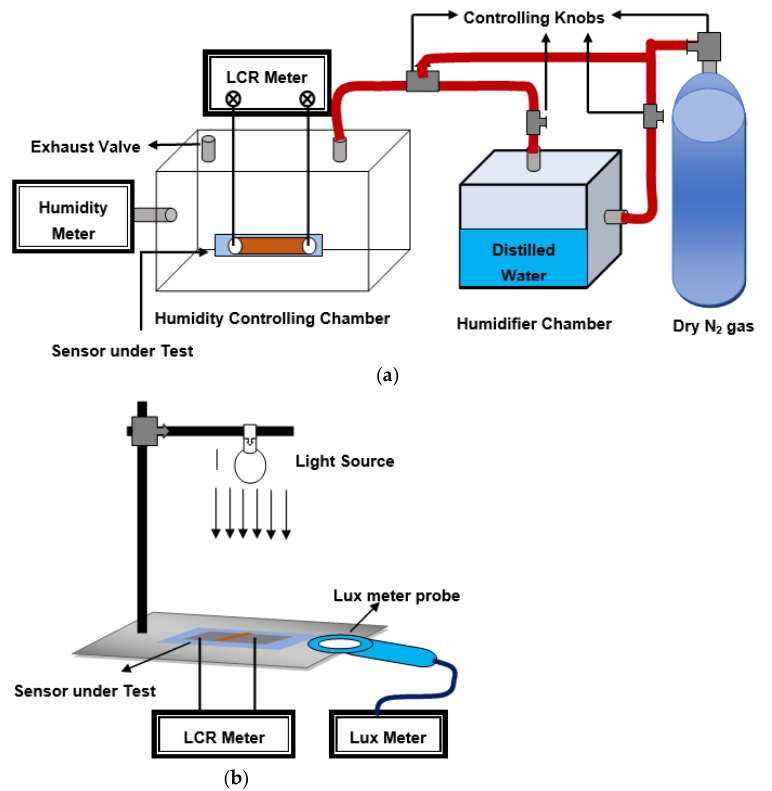
Figure 2. Schematic diagram of ( a ) humidity sensing setup and ( b ) light sensing setup.